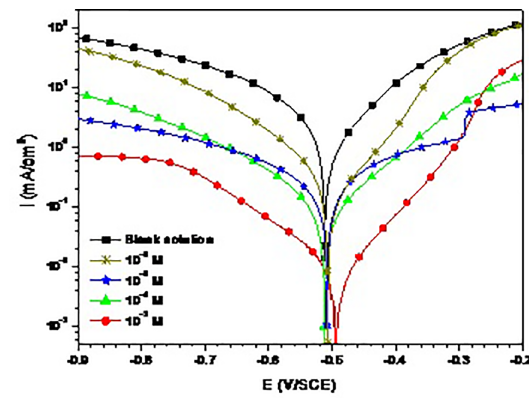
Figure 2. Evolution of EOCP versus time for mild steel in 1.0 HCl without and with different concentrations of CBIPM.